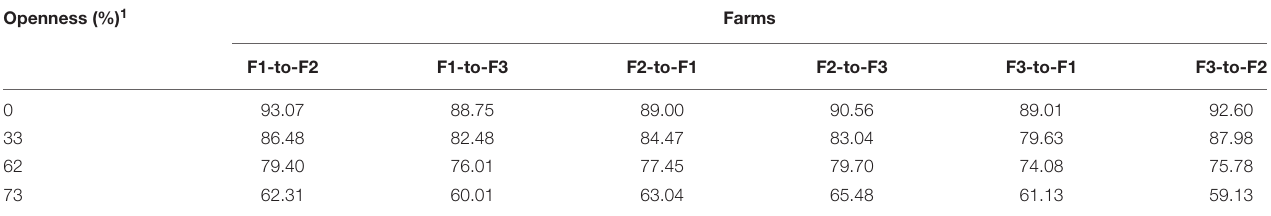
TABLE 5 | OS accuracy (%) for all classes including unknown across the combination of farms, averaged over three runs on the tomato diseases dataset. Openness (%) 1